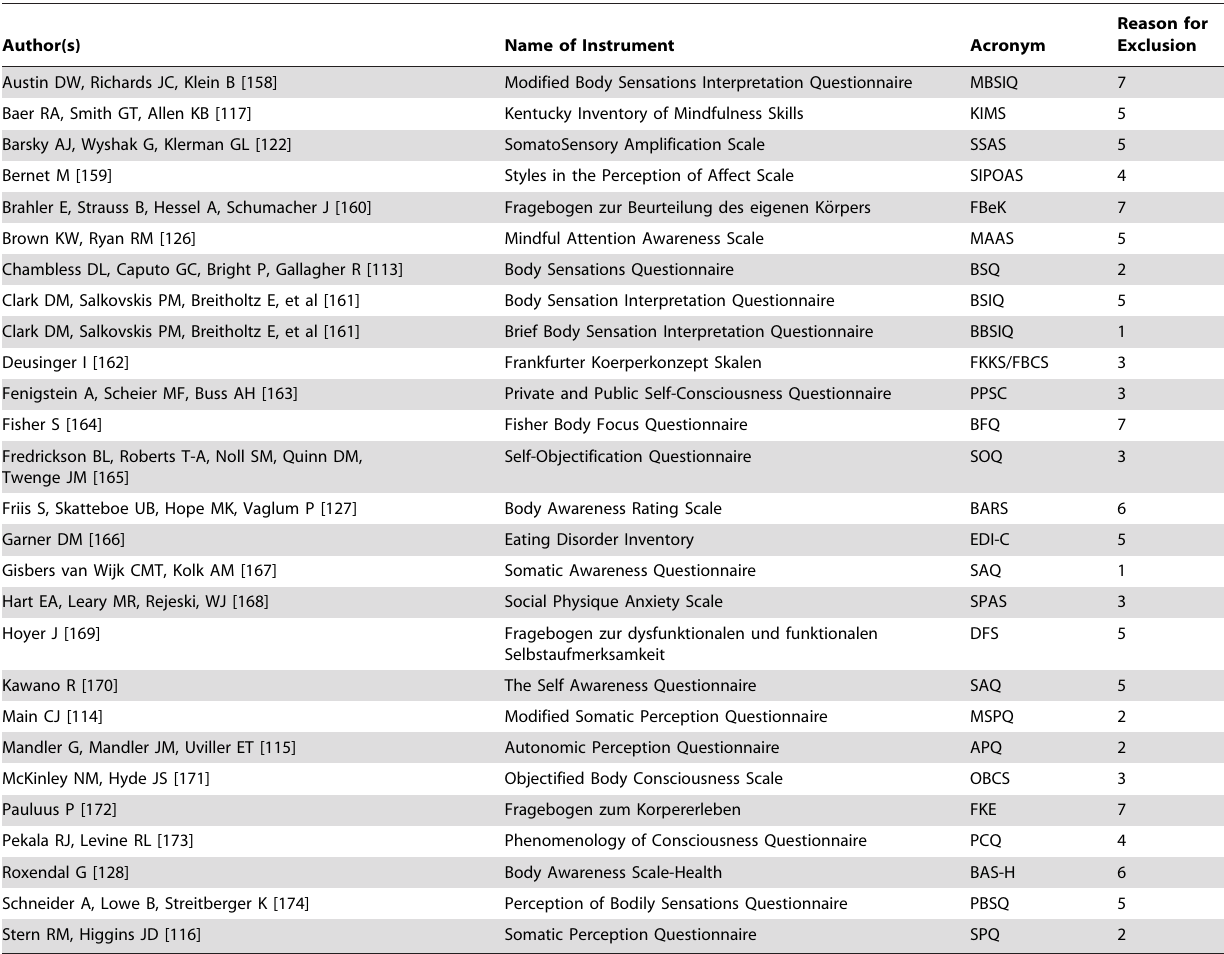
Table 1. Instruments Excluded from Psychometric Review and Reason for